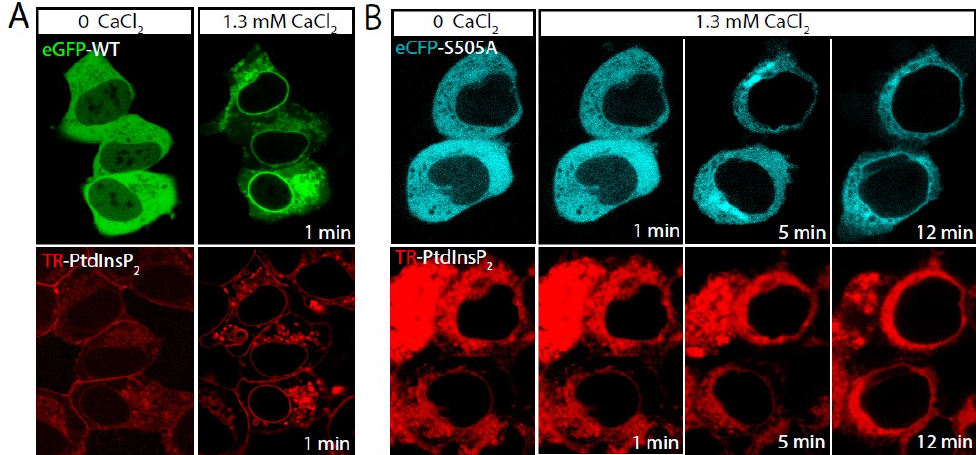
Figure 1. Translocation of eGFP-cPLA 2 α and eCFP-S505A-cPLA 2 α in response to PtdInsP 2 . HEK cells stably transfected with eGFP-cPLA 2 α ( A ) or the mutant eCFP-S505A-cPLA 2 α ( B ) were incubated with TR-PtdInsP 2 /histone in the absence of extracellular Ca 2+ (labeled as 0 CaCl 2 ) for 10 min. Afterward, 1.3 mM CaCl 2 was added to the medium to restore extracellular calcium levels (labeled as 1.3 mM CaCl 2 ). Pictures were taken under the confocal microscope at the indicated time points. Upper panels show the fluorescence from the cPLA 2 α constructs, while lower panels show fluorescence from the TR-PtdInsP 2 .